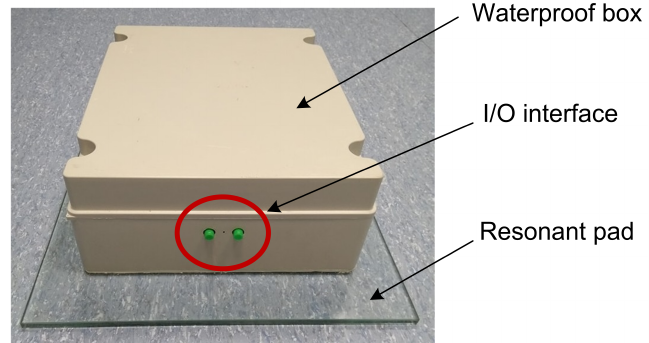
Figure 3. Sensor design with red labeled part included a I/O interface by FC/APCconnectors.